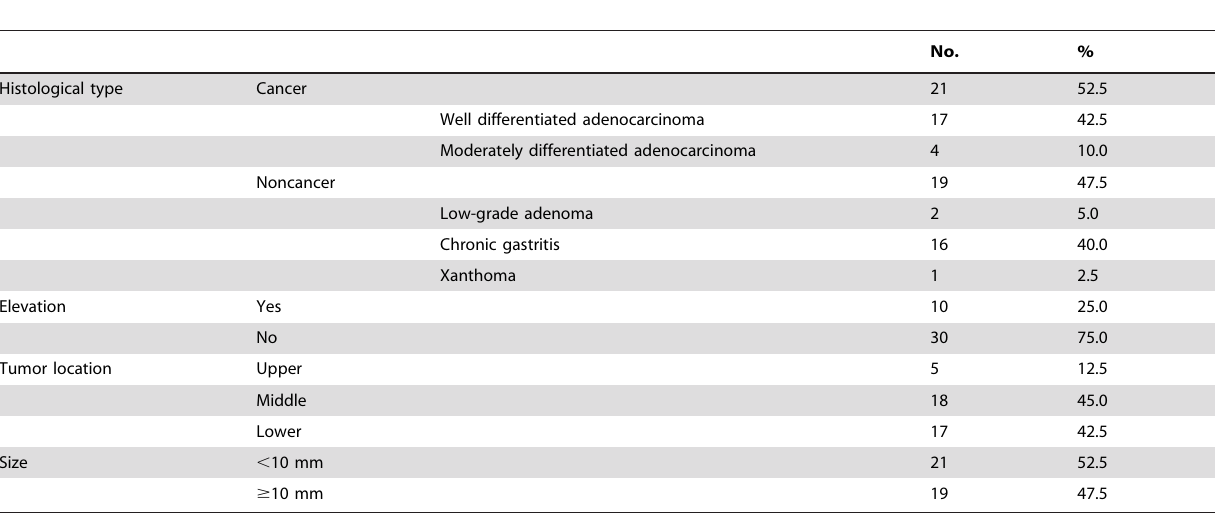
Table 1. Characteristics of 40 Gastric Lesions Used in Both